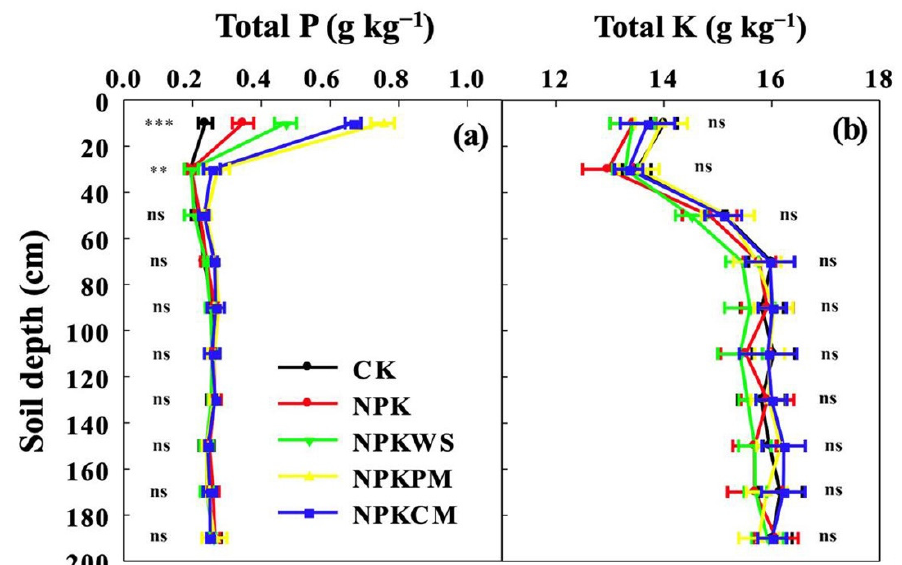
Figure 3. Total P and total K contents in the 0–200 cm depth after 32 years of fertilization in Vertisols. ( a ) Total P and ( b ) total K. CK: no fertilization; NPK: chemical fertilizers; NPKWS: NPK plus wheat straw; NPKPM: NPK plus pig manure; NPKCM: NPK plus cattle manure. The asterisks indicate significant differences among planting systems within the same soil layer, ** p < 0.01, *** p < 0.001; ns: not significant.